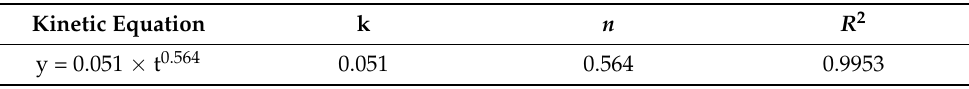
Table 2. Kinetic parameters for 310 H samples in supercritical water.